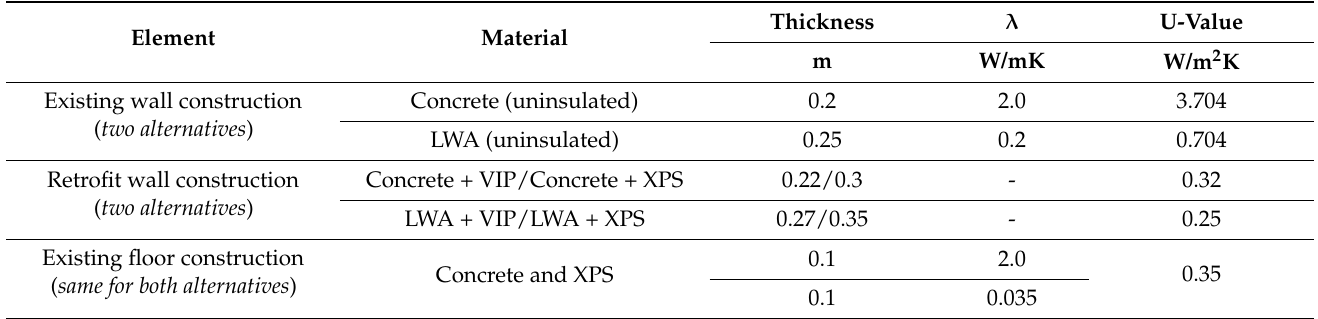
Table 1. Material parameters and U-values of existing and retrofit wall construction. LWA = light weight